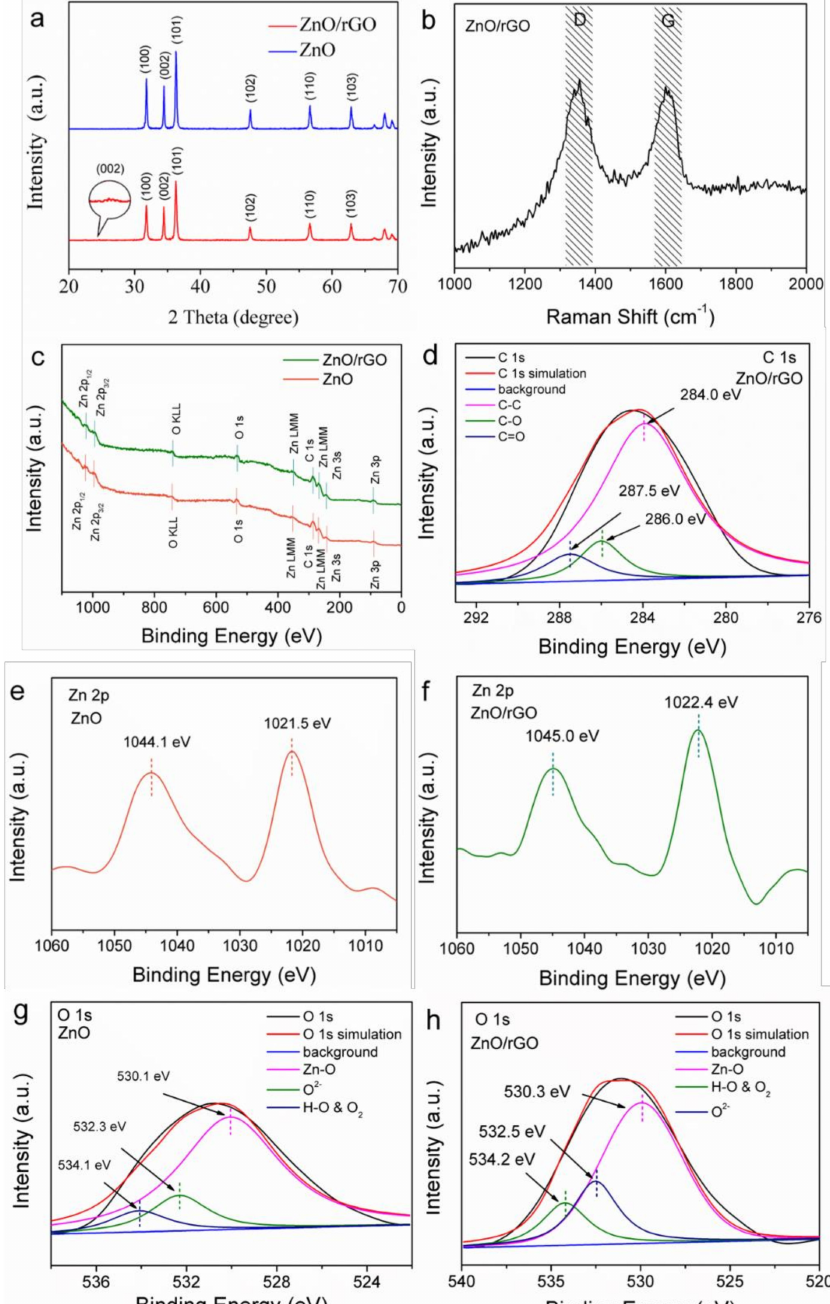
Figure 1. ( a ) X-ray diffraction patterns of ZnO and ZnO/rGO. ( b ) Raman spectrum of ZnO/rGO. ( c ) XPS survey spectra of ZnO and ZnO/rGO. Typical high-resolution XPS spectra of C 1s in ZnO/rGO ( d ), Zn 2p in ZnO ( e ) and ZnO/rGO ( f ). Typical high-resolution XPS spectra of O 1s in ZnO ( g ) and ZnO/rGO ( h